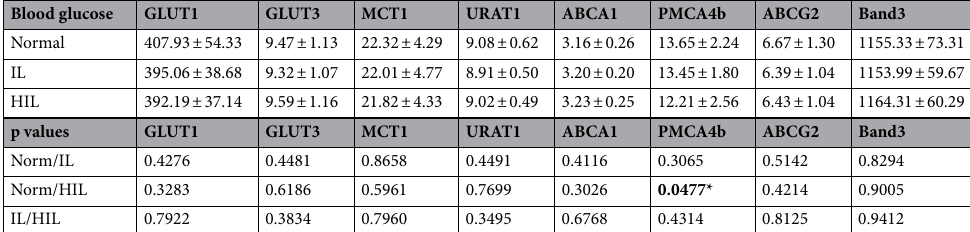
Table 4. The protein expression values are expressed as means ± SD.